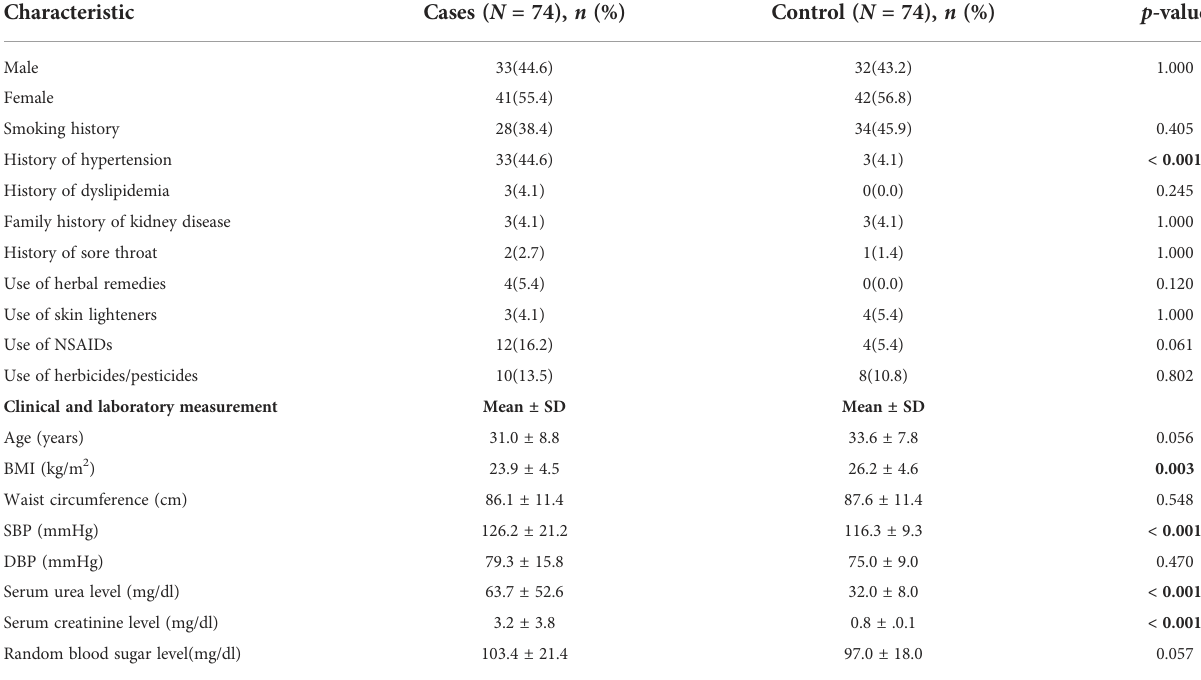
TABLE 1 Demographics, clinical characteristics, and laboratory parameters of cases and